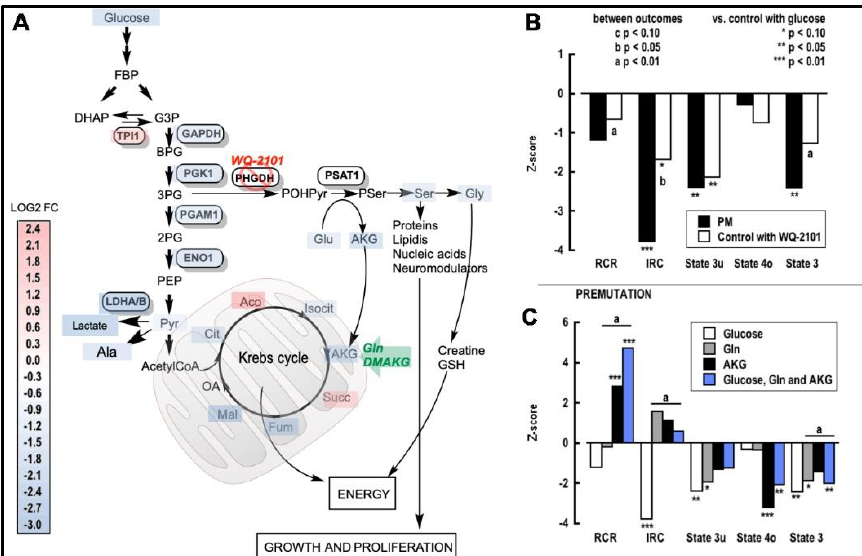
Figure 4. Role of Ser in the PM energy metabolism. ( A ) Metabolites and proteins identified in this study associated with glycolysis and the TCA cycle, whose levels were different between diagnostic groups, are shown in red (upregulated) or blue (downregulated). Intervention with dimethyl α -ketoglutarate (DMAKG), a membrane-permeable ester of AKG, is shown with a green arrow. Inhibition of the Ser biosynthetic pathway by WQ-2101, a potent and selective competing allosteric inhibitor of phosphoglycerate dehydrogenase (PHGDH), is shown in red. ( B ) Treatment with 25 µM WQ-2101 was carried out on 2 control umbilical cord fibroblasts, as described in the Methods section. After 24 h, cells were evaluated for oxygen consumption in the presence of 4 mM glucose (State 3), followed by addition of oligomycin (State 4o) and FCCP (State 3u). The same outcomes were recorded in 2 PM umbilical cords under the same conditions. Statistical analysis was performed using Student’s t test, for the comparison between PM and WQ-2101-treated control fibroblasts. Multiple groups were analyzed using ANOVA followed by Tukey’s post -hoc test. ( C ) The same mitochondrial outcomes were tested in PM umbilical cord fibroblasts in the presence of glucose (4 mM), Gln (2 mM), DMAKG (3 mM), and the combination of the three substrates. Bar graphs are shown as Z-scores. RCR: respiratory control ratio; IRC: index of respiratory capacity.